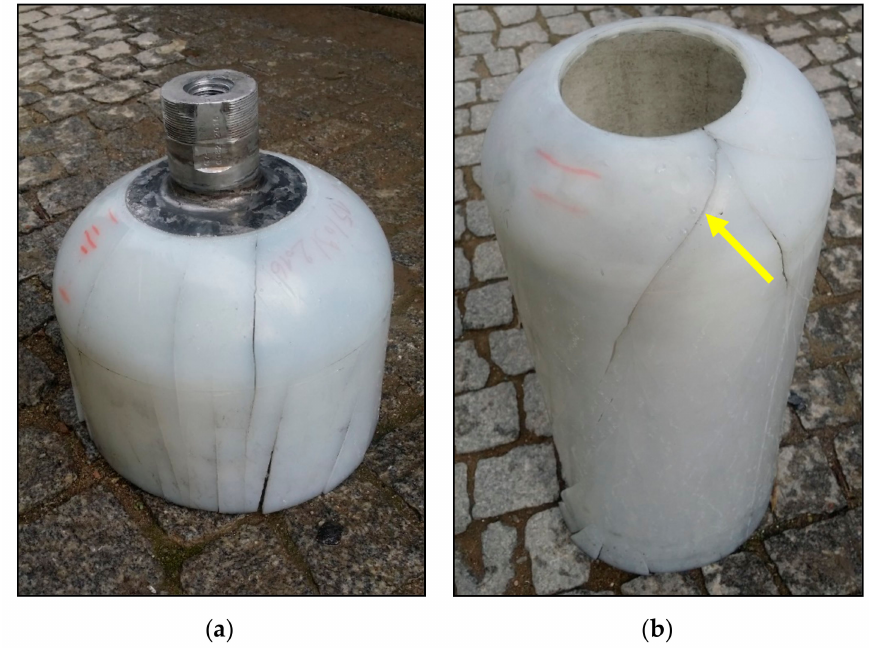
Figure 4. PE liner with major cracks extracted from a 700-bar hydrogen vessel after cyclic pressure test at low temperature. ( a ) Cut-off dome with the inlet boss and ( b ) the liner without the boss, which fell off due to the cracks at the liner material